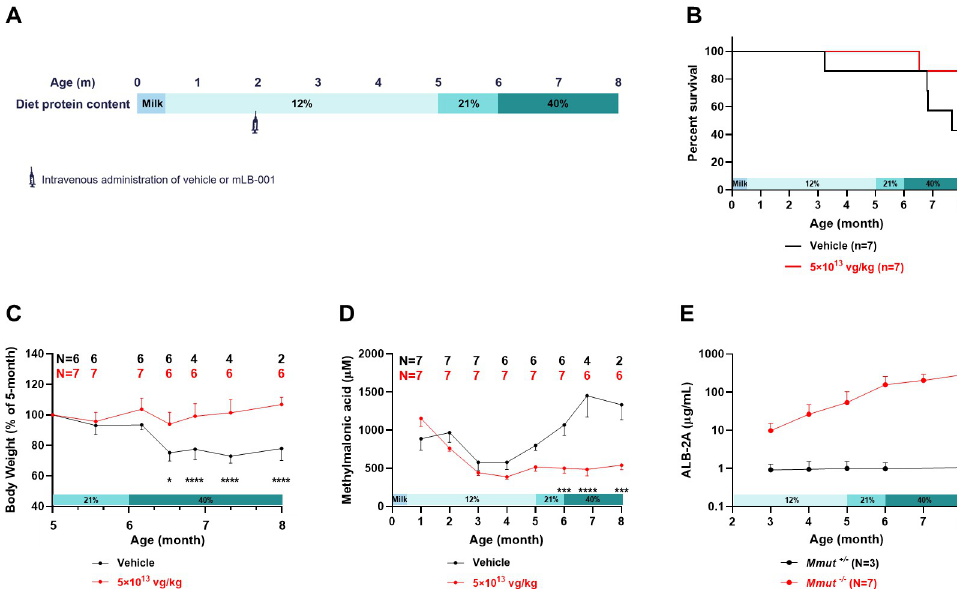
Fig 5. Effect of high protein diet challenge on MMA mice treated with vehicle or 5 × 10 13 vg/kg mLB-001 at 8 weeks of age. (A) Study design. Animals were maintained on the 12% protein diet and dosed with vehicle or mLB-001 at 8 weeks of age. At 3 months post-dosing, the diet was switched to the standard chow with 21% protein content and then to a 40% protein diet at 4 months post-dosing. Necropsy was performed at 6 months post-dosing when the mice were approximately 8 months old. (B) Kaplan-Meier survival curves of MMA mice show that the mLB-001-treated group survived longer than the vehicle-treated group ( P = 0.052, Log-rank test). (C) Change in body weight of MMA mice in response to the high protein diet challenge. The body weight of each animal was normalized to its weight at the introduction of the 21% protein diet. Females and males were combined due to lack of significant difference. Animal numbers at each timepoint are indicated above the graph. � P < 0.05, ���� P < 0.0001, mixed-effects analysis with multiple comparisons between vehicle- and mLB-001-treated groups at the indicated timepoints. (D) Circulating methylmalonic acid in the mLB-001-treated animals maintained at low levels but elevated in the vehicle-treated animals in response to high protein diet challenge. ��� P < 0.001, ���� P < 0.0001, mixed-effects analysis with multiple comparisons between vehicle- and mLB-001-treated groups at the indicated timepoints. (E) Plasma ALB-2A levels remained stable in the mLB-001-treated heterozygous animals while demonstrating exponential increases over time in the MMA